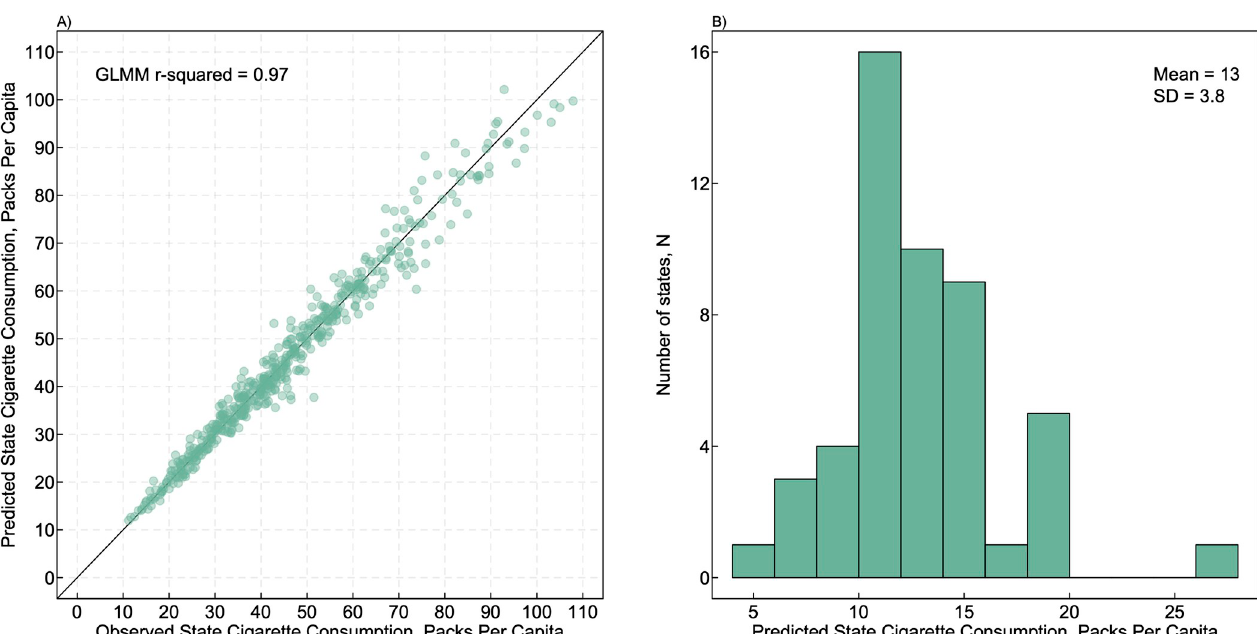
Fig 1. Observed and predicted cigarette consumption. A , Each dot represents observed cigarette consumption levels from 2011–2020 (x-axis) plotted against predicted consumption levels (y-axis) estimated from a model that included smoking prevalence estimates from the 2011–2020 Behavioral Risk Factor Surveillance System and a random effect for states (the model is shown in Table B in S1 Appendix and described in the methods). B , shows the distribution of values based on predictions from the model to 5% smoking prevalence for each of the 50 US states.